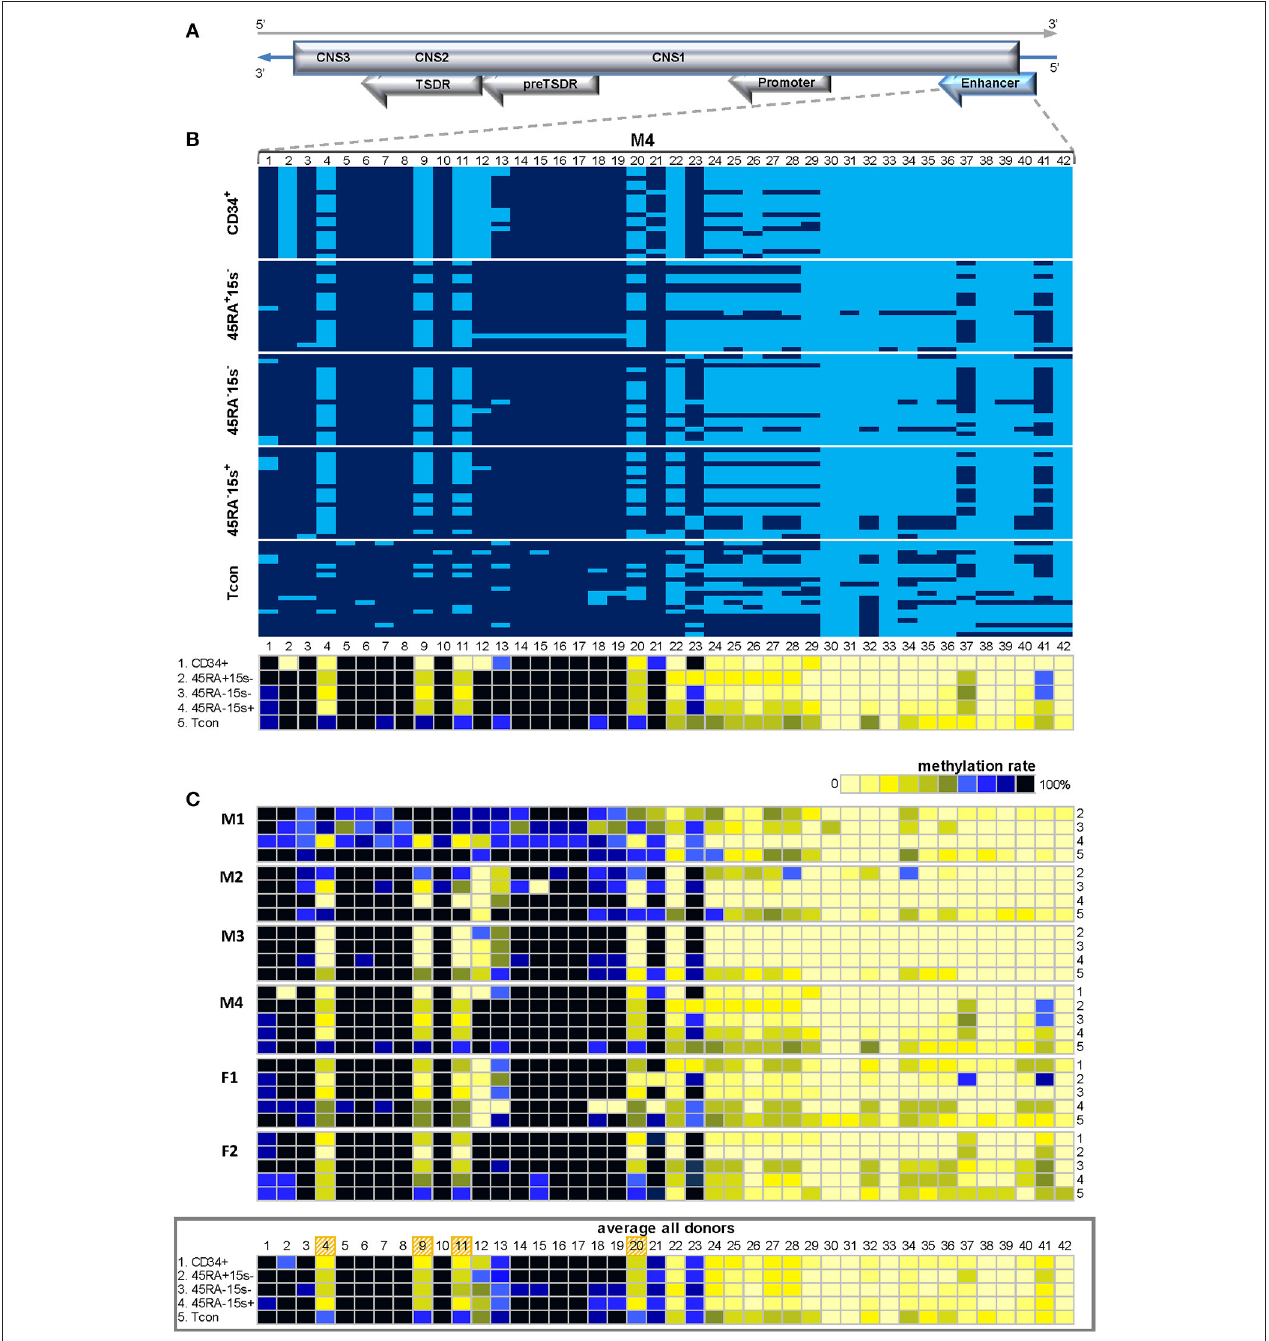
FIGURE 4 | Methylation pattern of FOXP3 enhancer. CpGs 4, 9, 11, 20, and 24–28 within FOXP3 enhancer are more demethylated in CD34 + cells and Treg subtypes as compared to Tcon. (A) Schematic presentation of the FOXP3 enhancer encoded in the reverse strand of Xp11.23. (B) Methylation pattern of the FOXP3 enhancer in five cell populations: CD34 + (1), CD45RA + CD15s − (2), CD45RA − CD15s − (3), CD45RA − CD15s + (4), and Tcon (5), of representative donor M4. CpGs 1-42 are numbered relative to the 5 ′ -3 ′ direction of the coding (reverse) strand. Each horizontal line represents DNA from one cell with unmodified C in light blue and m C in dark blue. Methylation percentage for each CpG site was calculated based on the number of m Cs in a total of 20 and summarized in panels below. (C) Methylation patterns of the FOXP3 enhancer of individual donors with the average methylation pattern for all donors presented in the panel below. See also Supplementary Figures 1 , 4 .